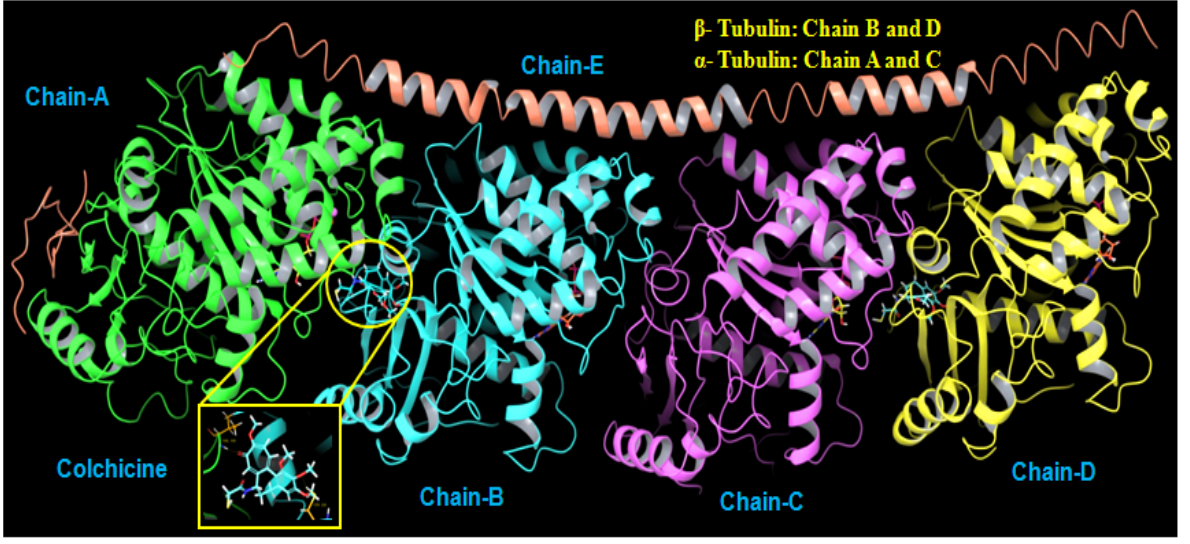
Figure 1. Colchicine-binding site (PDB: